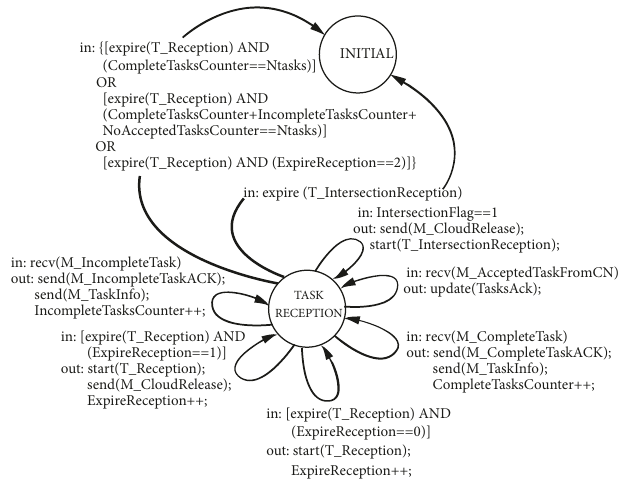
Figure 8: Transition from TASK RECEPTION to INITIAL